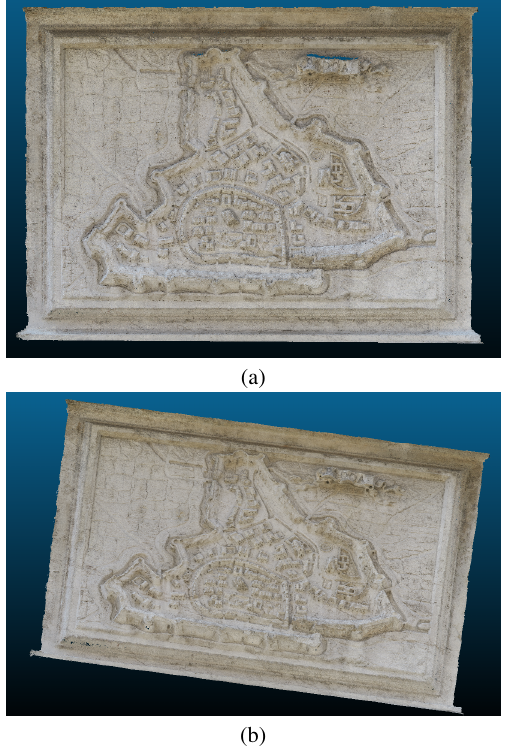
Figure 3. (a) Frontal view of the 3D model of the low relief. (b) Rotated view of the reconstructed low relief.